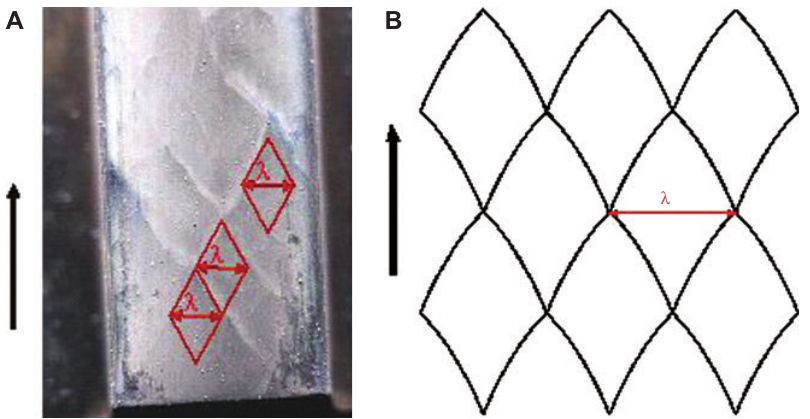
= 0.6 bar) λ = detonation cell width; , equivalence ratio = 1, p 2 0